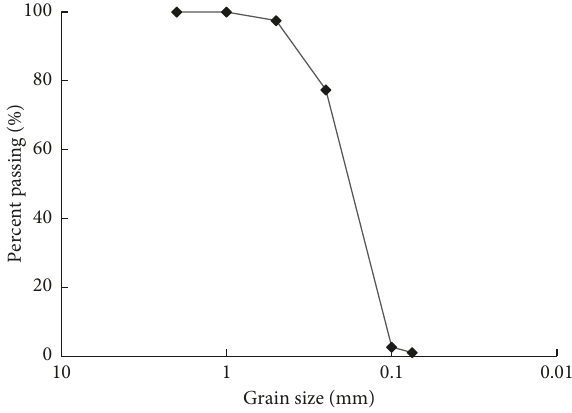
Figure 7: Grain size distribution of sand. Table 1: Model